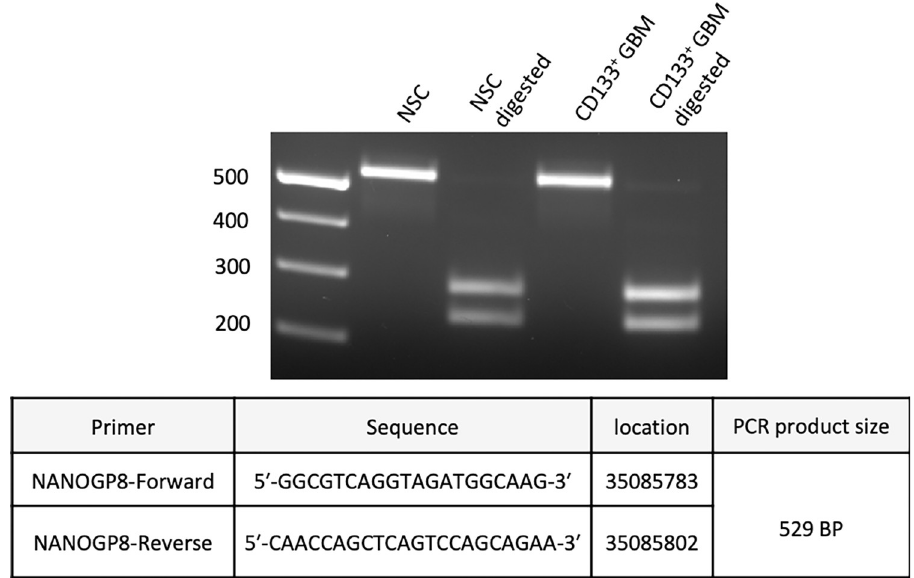
Fig 4. RFLP analysis of NANOGP8 gDNA PCR product. gDNA amplified with NANOGP8 primers. PCR product digested with HpyF3I. NSC and GBM show complete digestion, affirming the presence of the NANOGP8 transcript. A PCR product of 529 bp is digested to yield fragments of 287, 234, and 8 bp each. The 8 bp fragment is not visible in the image. S5 Raw image shows the details.